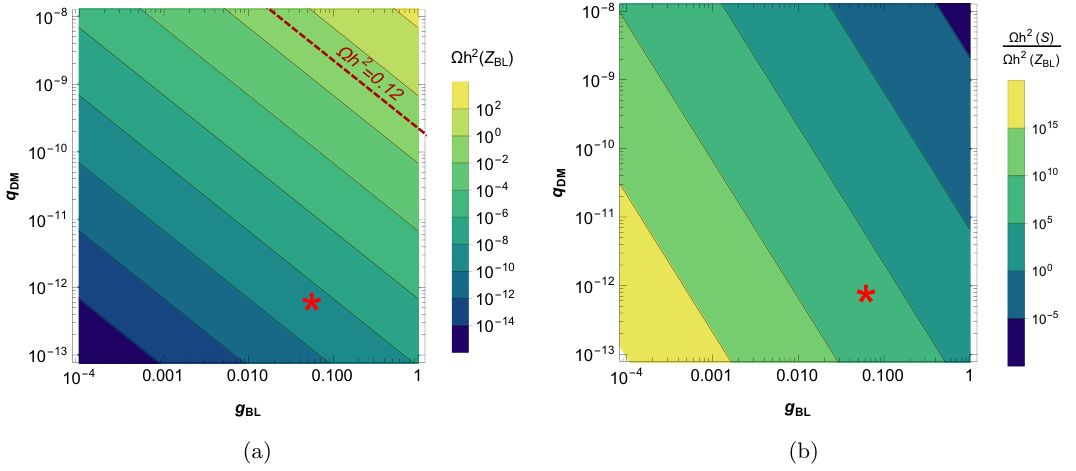
Figure 4 . Figure 4(a) shows contours of relic abundance of φ D in the g BL and q DM plane, where production of dark matter is governed by gauge interaction. Figure 4(b) shows contours of the ratio of relic abundance of φ from B − L Higgs boson S and Z decay. The parameters chosen D BL are as follows, m =1 GeV, m =5.5 TeV, m =200 GeV and λ = 10 − 13 . The red star in φ DM Z BL S SD figure 4(a) and figure 4(b) represents our benchmark